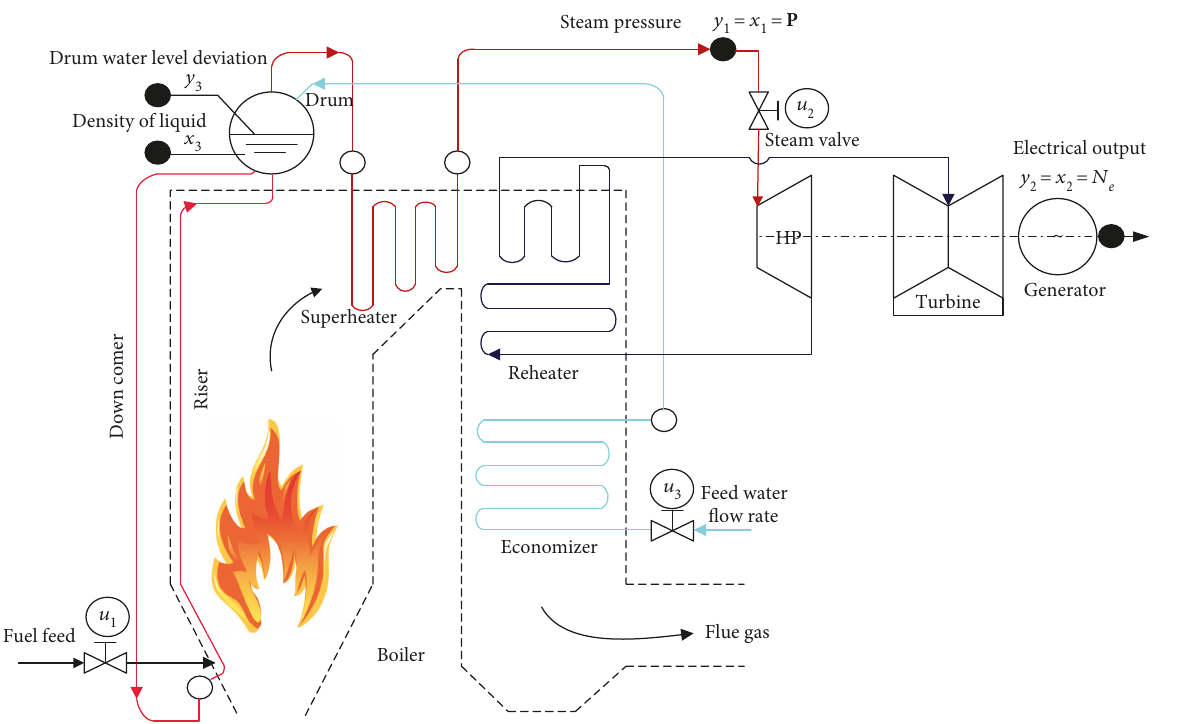
Figure 1: Structure of a 160 MW boiler-turbine unit in a thermal power